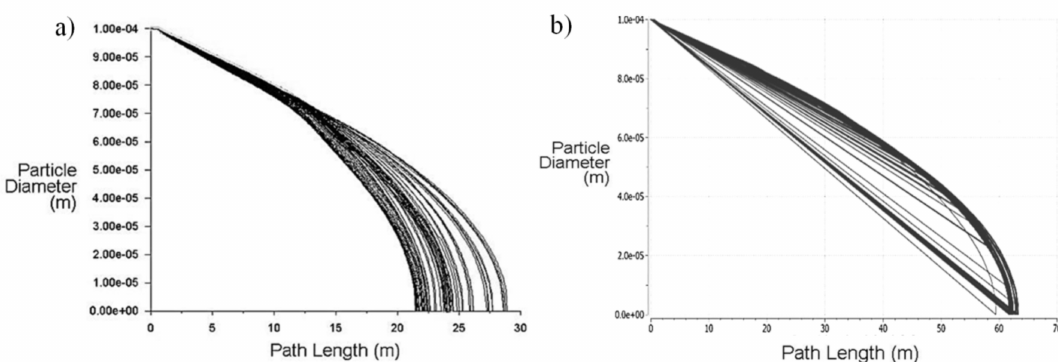
Figure 13. Predicted distribution of aerosol droplet changes 100 µ m in diameter obtained from the CFD model: ( a ) Ansys- Fluent, ( b ) Ansys-CFX.